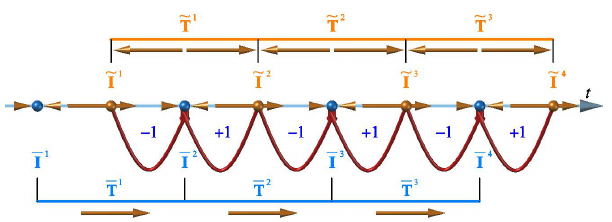
Figure 13: Orientations of the primal and dual time elements for the case of four instants.